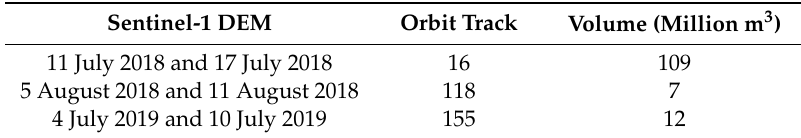
Table 3. Volume estimation of the landslide based on the Sentinel-1 derived post-event DEMs and the pre-event ArcticDEM.